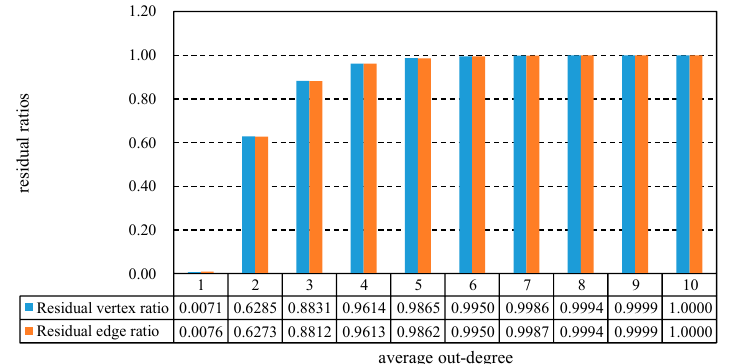
Figure 6. Ratio of number of residual vertices and arcs after simplification.